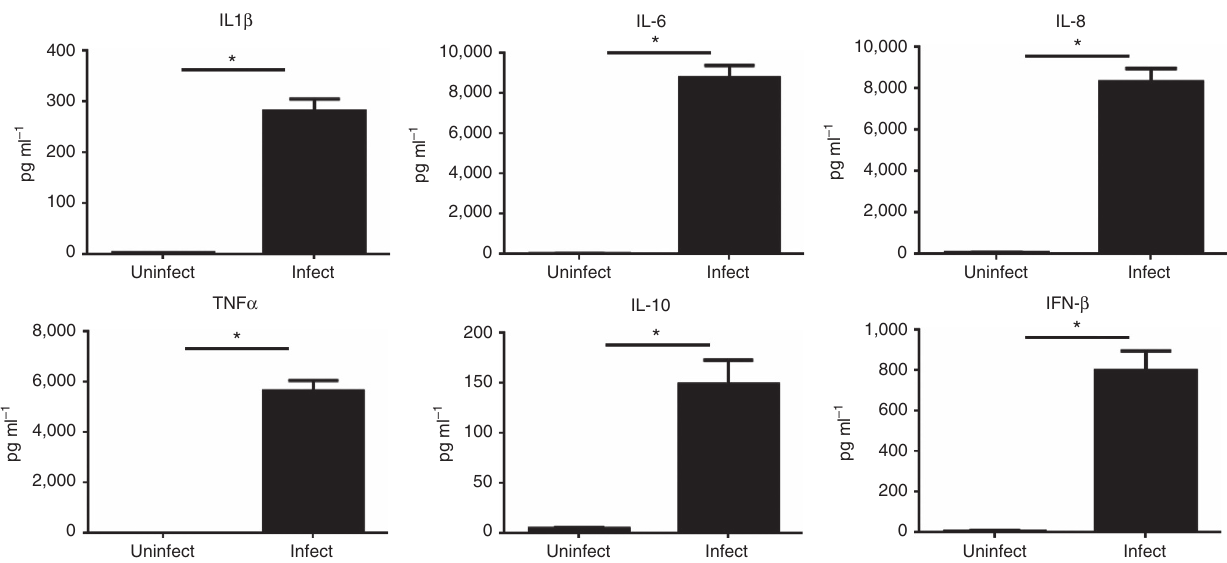
Figure 4 | Overproduction of cytokines in human iPSdMs after infection with C. trachomatis for 24h. Results are the average of three independent measurements ± s.d. using the Luminex customised anti-human cytokine Milliplex kit. *Represents statistically significant different ( P o 0.05) between uninfected and Chlamydia- infected as determined using two-way ANOVA.